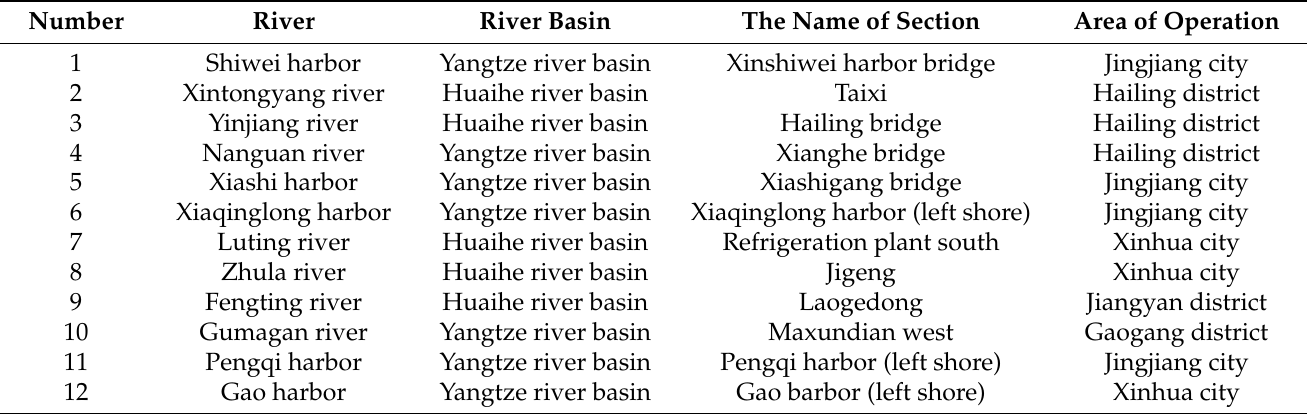
Table 2. Information of water quality automatic monitoring